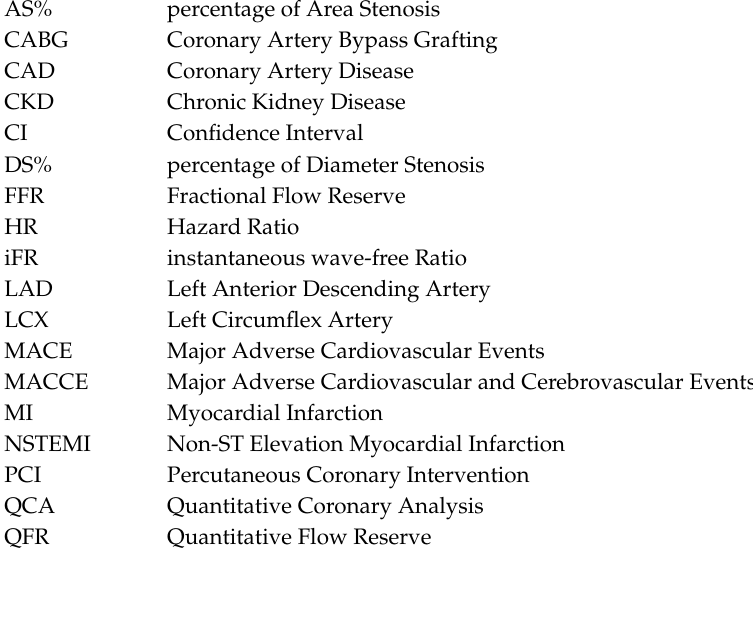
Supplemental Figure S1: Mountain Plots of QFR reproducibility, Supplemental Figure S2: QFR Kaplan–Meier event-free survival curves of patients without a prior history of revascularization, Supplemental Figure S3: Kaplan–Meier curves describing event-free survival of QFR ≤ 0.80 concerning individual endpoints, Supplemental Figure S4: Kaplan–Meier curves describing event-free survival of QFR ≤ 0.90 concerning individual